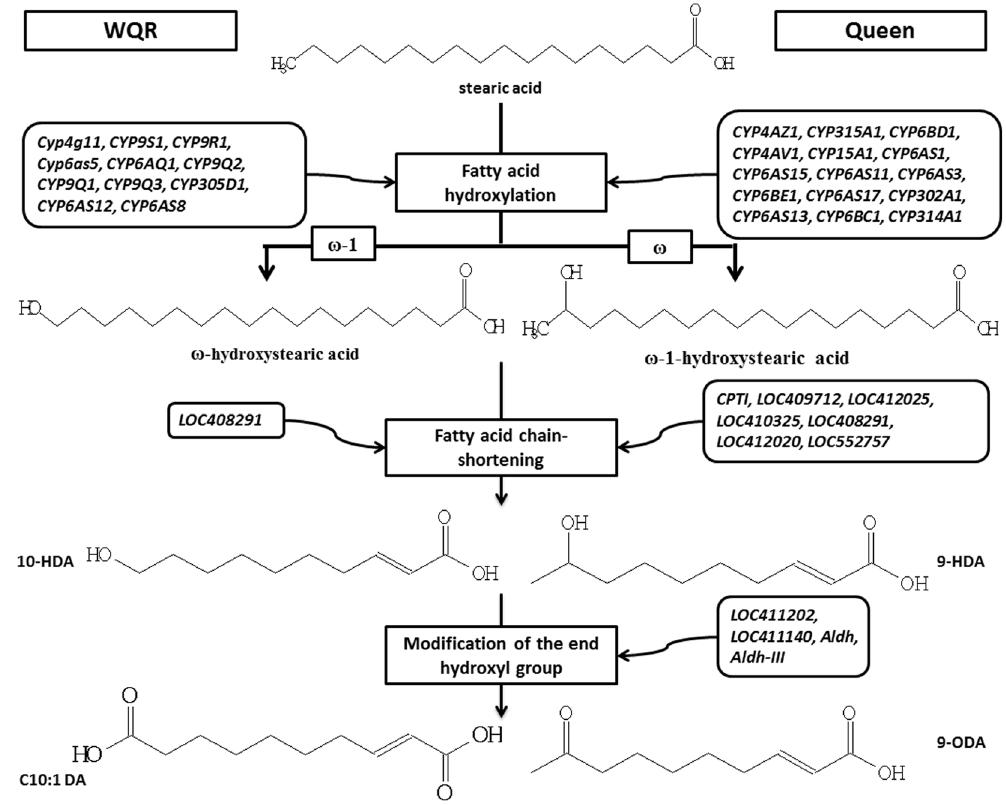
Figure 1. The putative biosynthesis pathway of honey bee mandibular gland secretions and possible related DEGs. Genes listed on the right side are the DEGs highly expressed in Queen library comparing to WQR library, genes on the left side are those highly expressed in WQR. Modified from Plettner et al . 14